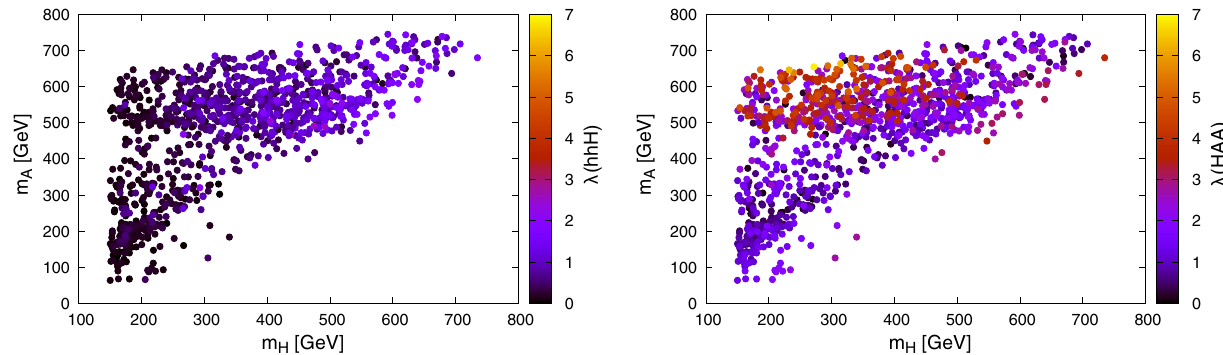
Fig. 6 Examples of s -channel diagrams considered for the production of three-body final states. Processes like the one on the right are not taken into account in the scatter plots shown above, as two of the three final state particles result from an incoming Higgs state that is necessar-